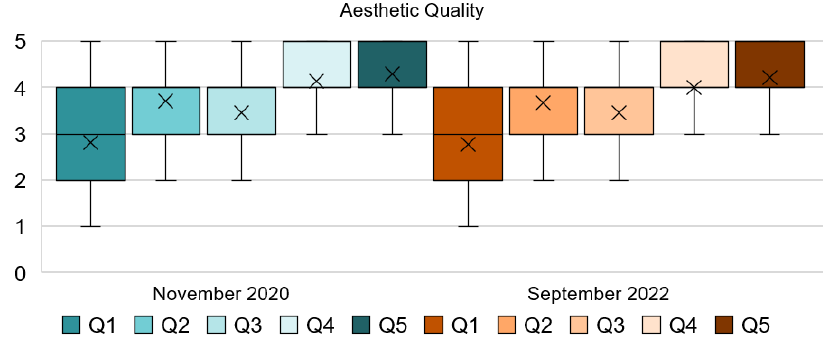
Figure 1. Interval data graph of the Aesthetic Quality dimension.